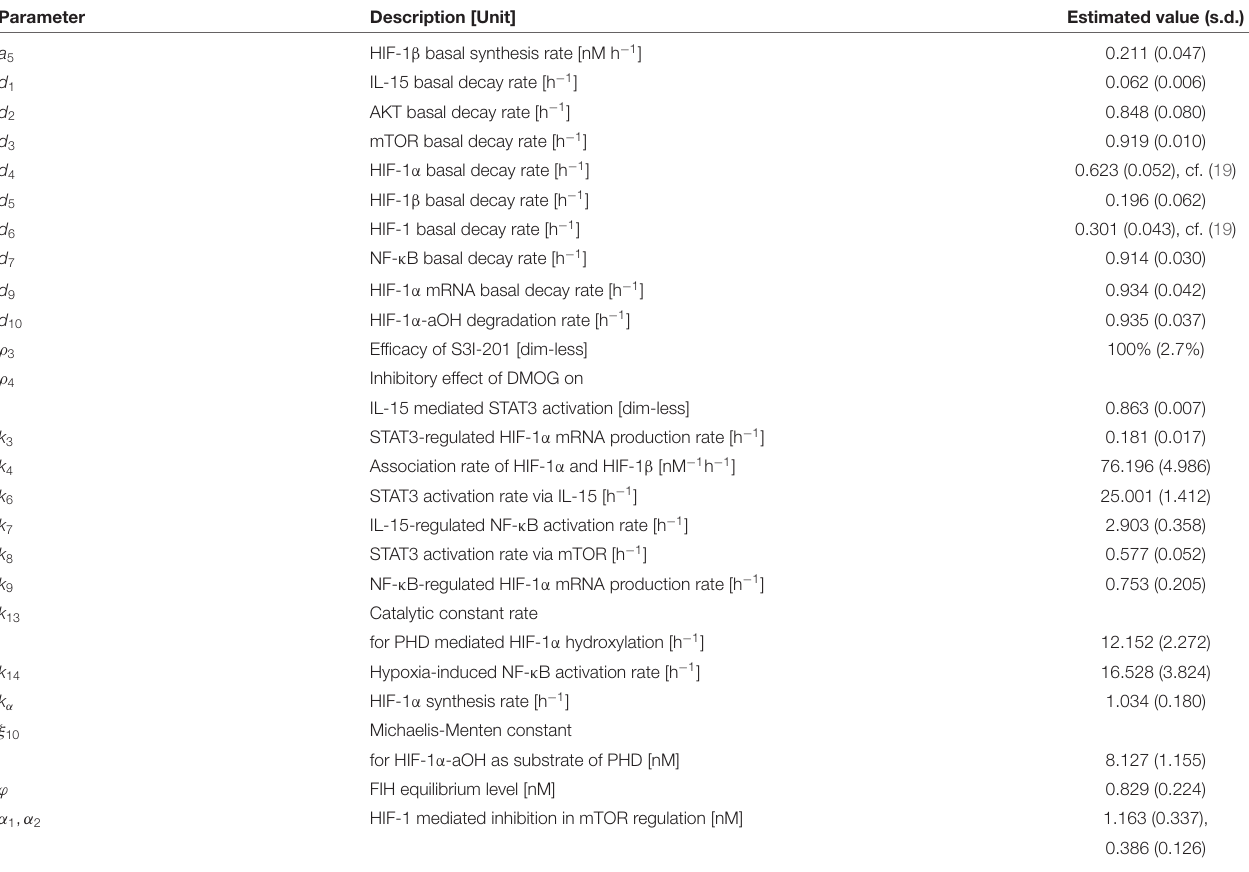
TABLE 2 | Parameter description and values used for the mathematical model (2)–(11).